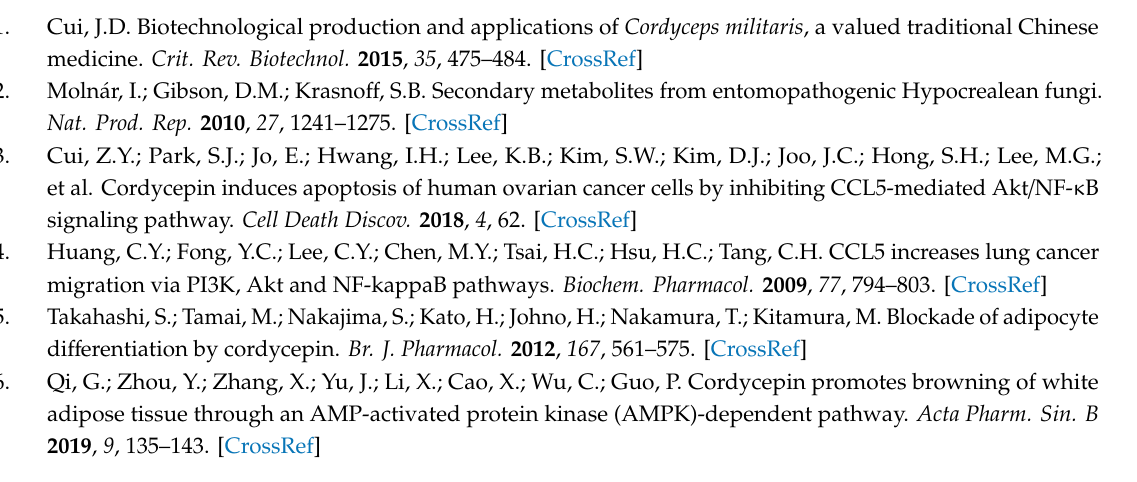
Table S1: A list of known / putative sugar transporter sequences from di ff erent fungi which was used for structural motif analysis. Table S2: A list of consensus features of sugar transportome of C. militaris . Table S3: A list of significantly expressed sugar transporter genes across three experimental sets of the C. militaris sucrose, glucose, and xylose cultures. Table S4: The total binding energy and its components of CCM_06358 as well as xylose complex obtained from g_mmpbsa tool. Figure S1: Ramachandaran plot of CCM_06358. Note: There was more than 98% of residues in the allowed region suggesting the high quality of the structure. Figure S2: Molecular docking results for xylose binding with CCM_O6358. Note: ( A ) The bonding pose of xylose at the entrance position, consisting of Gln50, Met311, and Thr315; ( B ) the bonding pose of xylose at the bottleneck position, consisting of Tyr85 and Asn445. Figure S3: Molecular dynamics (MD) setup and RMSD results for simulating the interaction of CCM_06358 and xylose. Note: ( A ) A representative CCM_06358 conformation observed in simulation. The CCM_06358 structure (orange) constructed by using homology which was embedded into a POPE lipid bilayer (green). The substrate xylose (purple) was initially placed on the bottleneck sites indicated by caver. Water molecules were displayed in red lines; ( B ) the RMSD of all C α atoms of CCM_06358 throughout 100 ns MD simulation for the